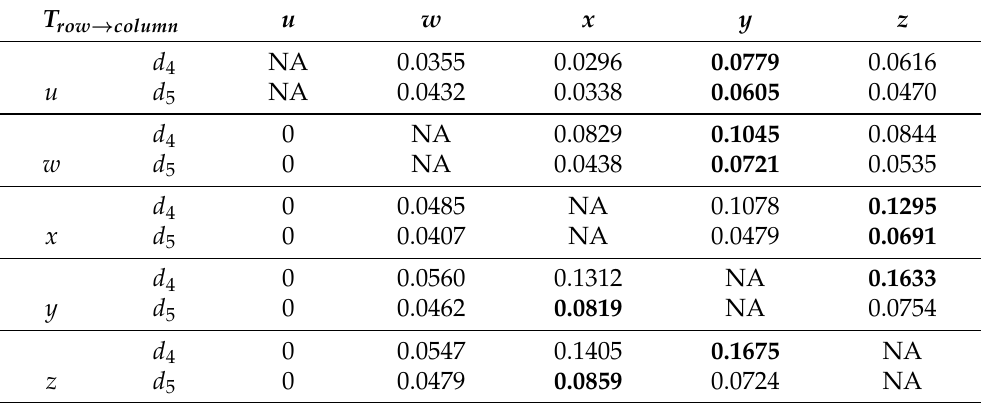
Table 8. Transfer Entropy coefficient for 2nd variant ( n divisor equals